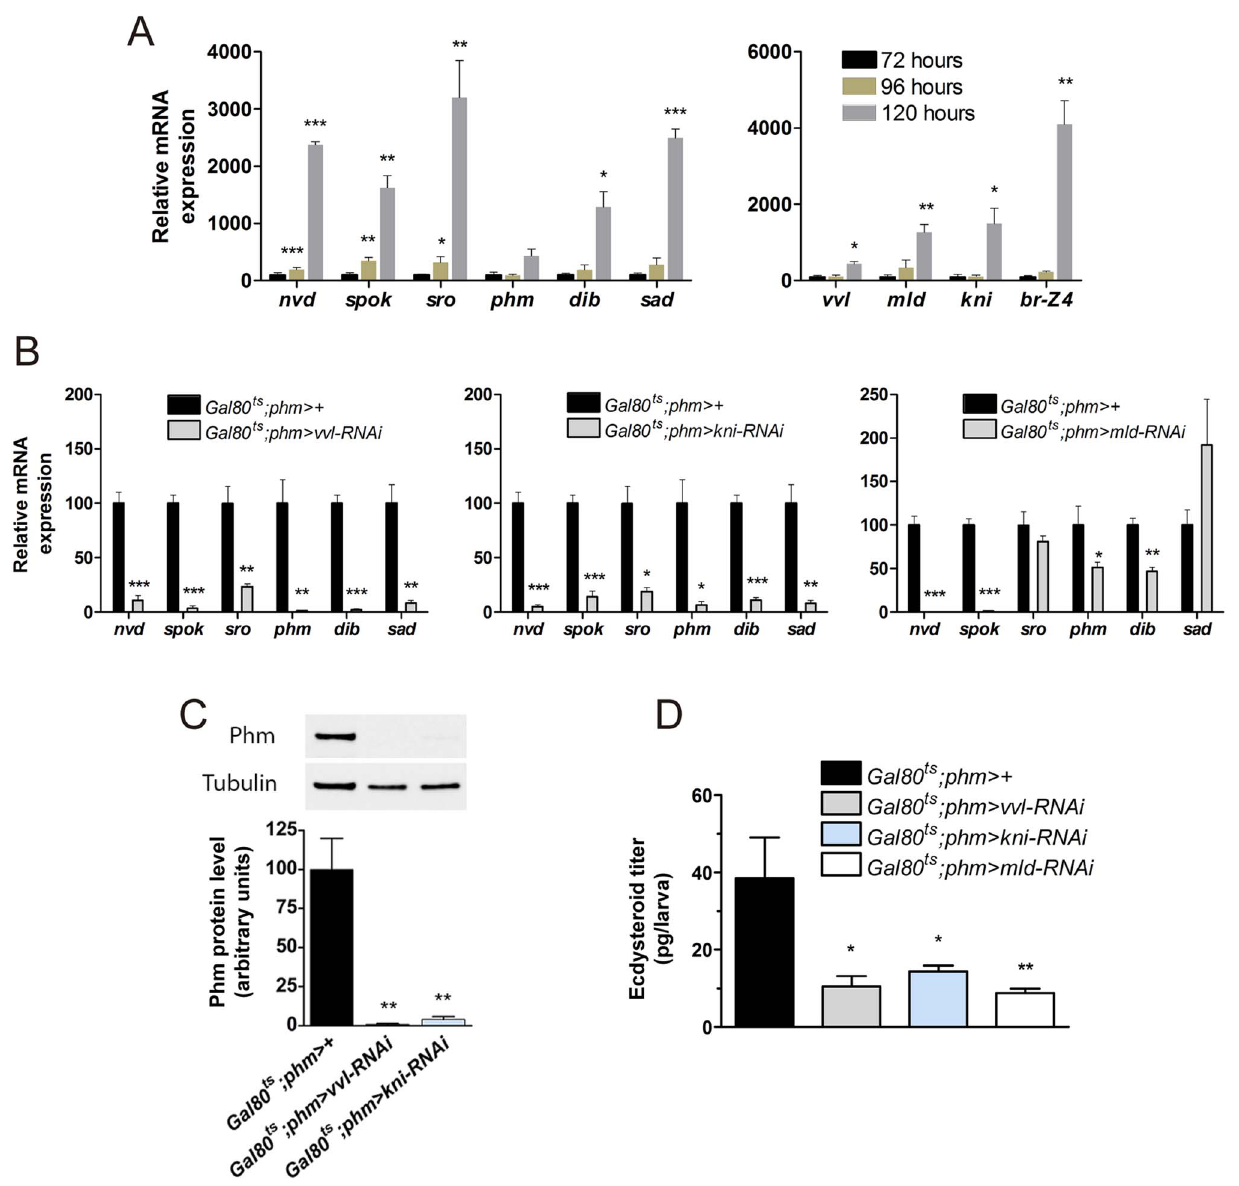
Figure 4. vvl , kni and mld have a specific role in regulating ecdysone biosynthesis in the L3 stage. (A) Expression of steroidogenic genes in ring glands from wild type ( phm-GFP ) larvae increases little from early (72 hours AEL) to mid (96 hours AEL) third instar, but rises dramatically in the late (120 hours AEL) third instar. vvl expression exhibits a minor increase in the late third instar, while mld , kni and especially Br-Z4 show a strong increase (n=4). (B) Expression in the ring gland from larvae with knock down of vvl , kni or mld during the L3 stage two days after temperature induced activation of the RNAi with the Gal80 ts ; phm . driver 96 hours AEL. Expression of all the steroidogenic genes were significantly reduced in animals with reduces vvl or kni expression. Knock down of mld results in a dramatic reduction in expression of nvd and spok that mediate two early steps in the biosynthesis of ecdysone (n=4). (C) Quantified level of Phm protein in brain-ring gland complexes (BRGCs) from L3 larvae two days after temperature induced RNAi (96 hours AEL) normalized to Tubulin levels determined by immunoblotting (top panel) (n=3). (D) Ecdysteroid levels determined by ELISA in L3 larvae with reduced PG expression of vvl , kni or mld two days after temperature induced activation of the RNAi effect (96 hours AEL) (n=4). Error bars indicate s.e.m. * P , 0.05, ** P , 0.01, *** P , 0.001, versus the Gal80 ts ;phm . +